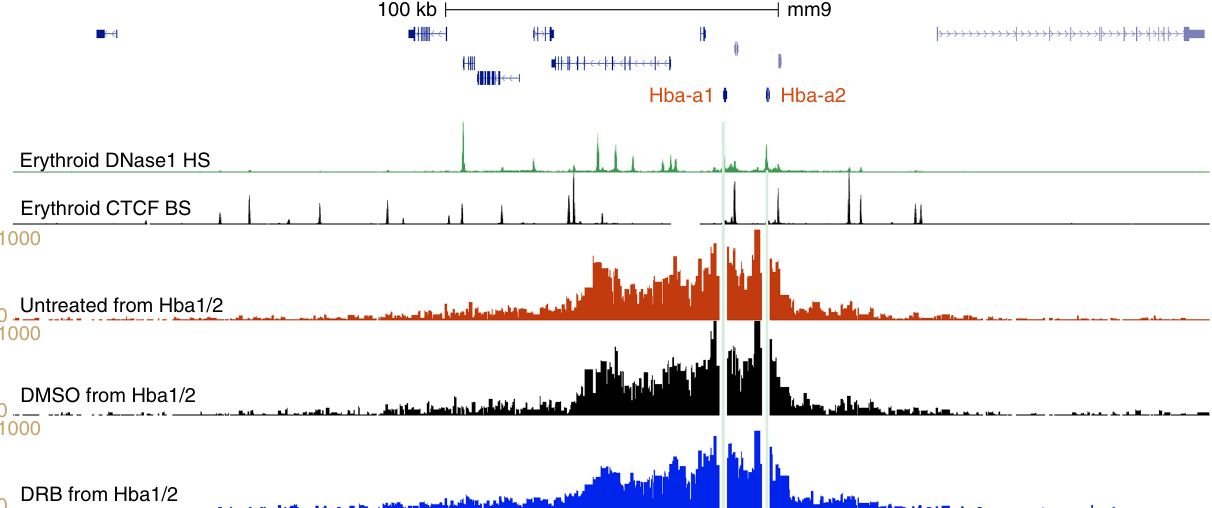
Fig. 9 Transcriptional elongation is not required for the maintenance of domain structure. Gene map with DNase1 HS (green) and CTCF BS (black) genome browser tracks, followed by NG Capture-C tracks from the Hba1/2 viewpoints in MFL 30 h cells untreated (red) and cultured for 3 h in presence of control DMSO (black) and DRB (blue), showing retention of interaction frequencies within the domain despite loss of